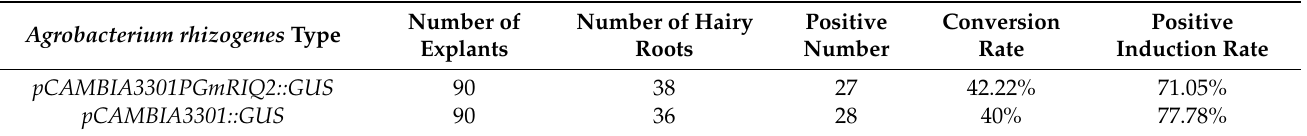
Table 5. Comparison of induction and transformation of hairy roots by different recombinant expression